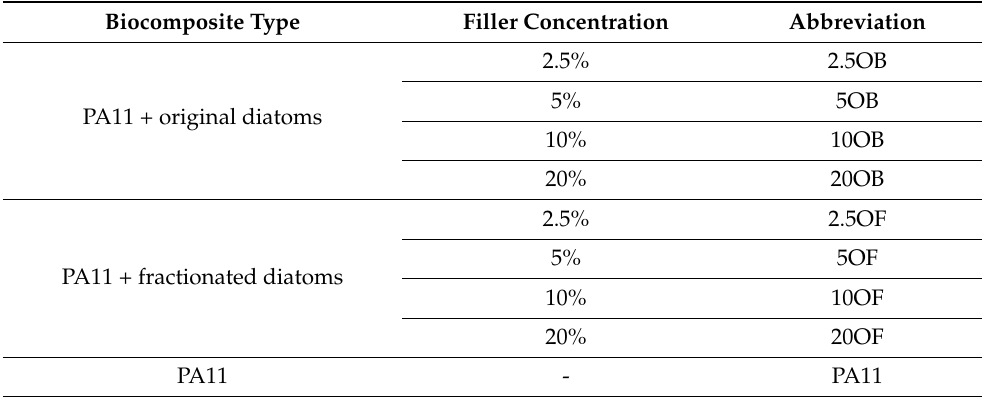
Figure 5. Biocomposites obtained by injection. Table 5. Bio composites to be tested.